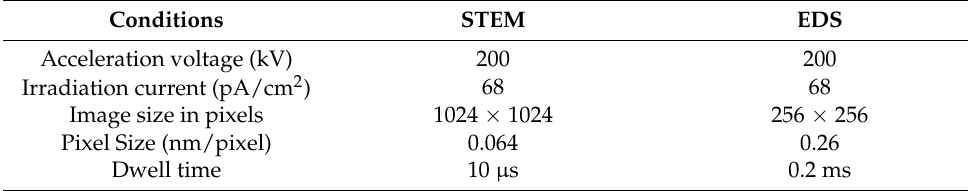
Table 4. Conditions of STEM and EDS